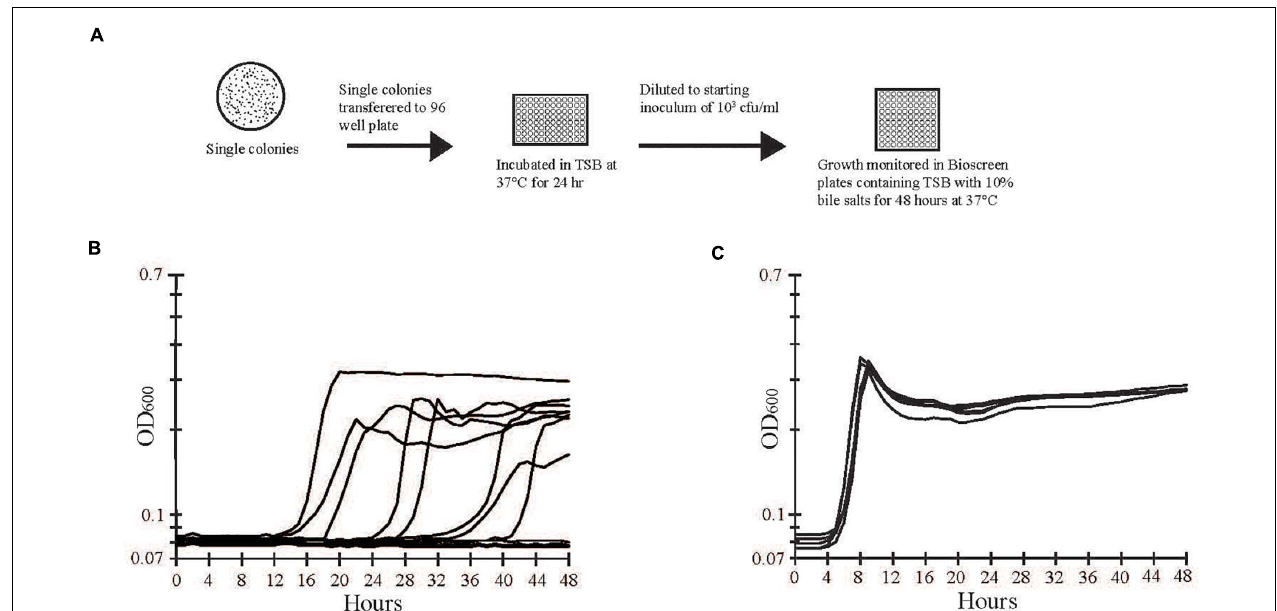
FIGURE 2 | Separation and screening of bile salts tolerant and sensitive strains. (A) A stock culture of strain E40 was grown in TSB and then diluted and plated on LB agar to obtain single colonies. Individual colonies were inoculated into separate wells of a 96-well plate containing TSB and incubated overnight at 37 ◦ C. Growth from each well was diluted to approximately 10 3 CFU/ml and used to inoculate separate wells of a Bioscreen plate containing TSB with 10% bile salts. Growth was monitored by optical density at 600 nm during incubation at 37 ◦ C for 48 h. (B) A representative sample of optical density measurements from growth -positive and -negative wells are shown. Growth varied in the length of lag phase, slope of exponential phase, and maximum optical density. (C) Cells from growth-positive wells in (B) were transferred to wells of a new plate with TSB and 10% bile salts. The lag, exponential, and stationary phases of growth were consistent among bile salts tolerant